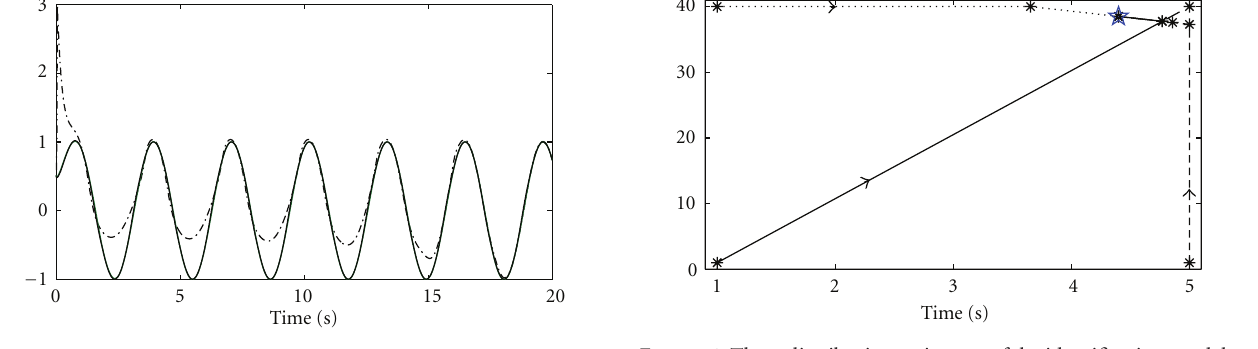
Figure 1: Output y ( t ). dash-dotted line for the classical adaptive control, dashed line for the multiple model case ( N = 200) as in [7], and solid line for the multiple identification model developed in this paper.